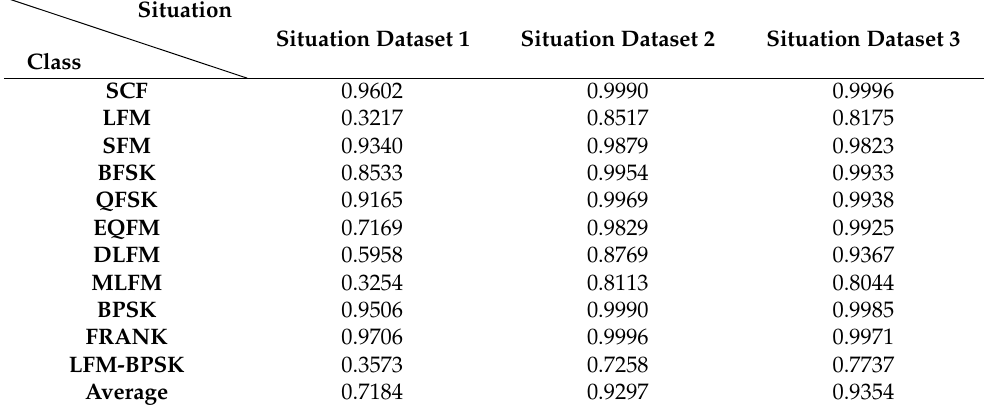
Table 5. The fully supervised classification accuracy for the classes with the datasets in Situation Dataset 1, Situation Dataset 2 and Situation Dataset 3.